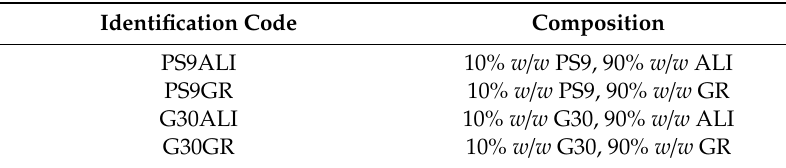
Table 3. Thermal muds tested, identification codes and composition. Identification